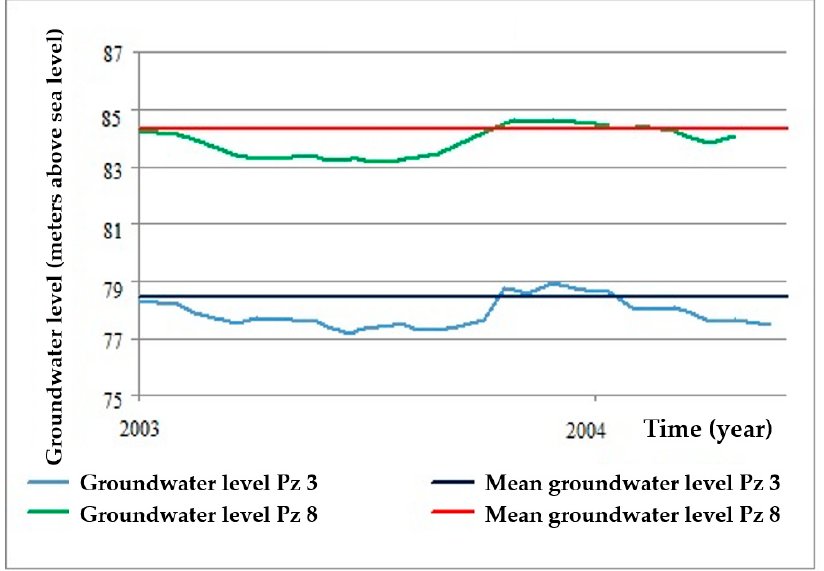
Figure 11. Fluctuations of groundwater levels at Pz 3 and Pz 8 during 2003 and 2004.